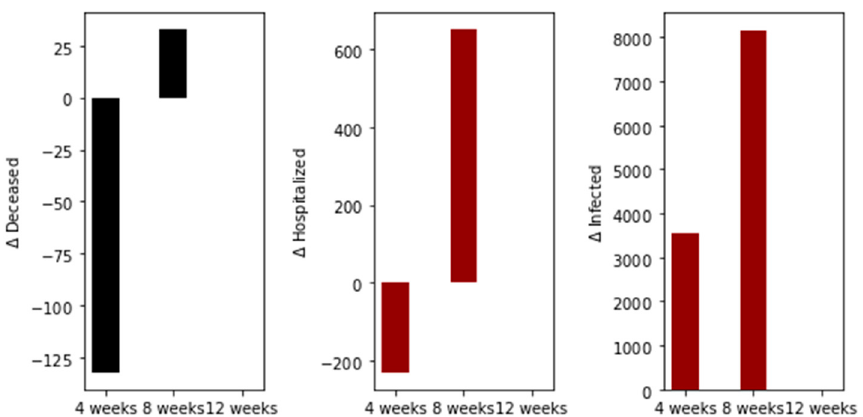
Figure 6. Differences in the total number of deaths, hospitalized, and infected, under the different time interval vaccine regimens. This scenario considers a transmission rate such that the basic reproduction number R 0 is less than one, the vaccination pace is just 100,000 per day, and the vaccine efficacy after the first dose is 60% and 95% after the second dose.